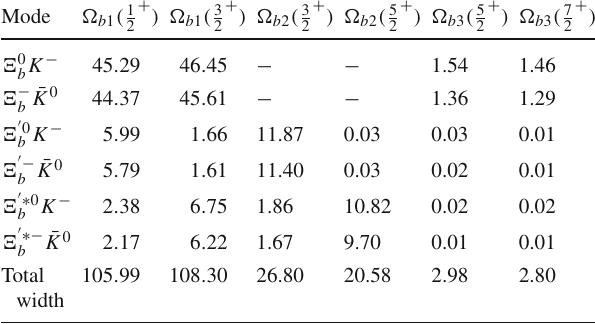
Table 4 Decay widths of the (cid:2) b ( 1 D ) states in MeV